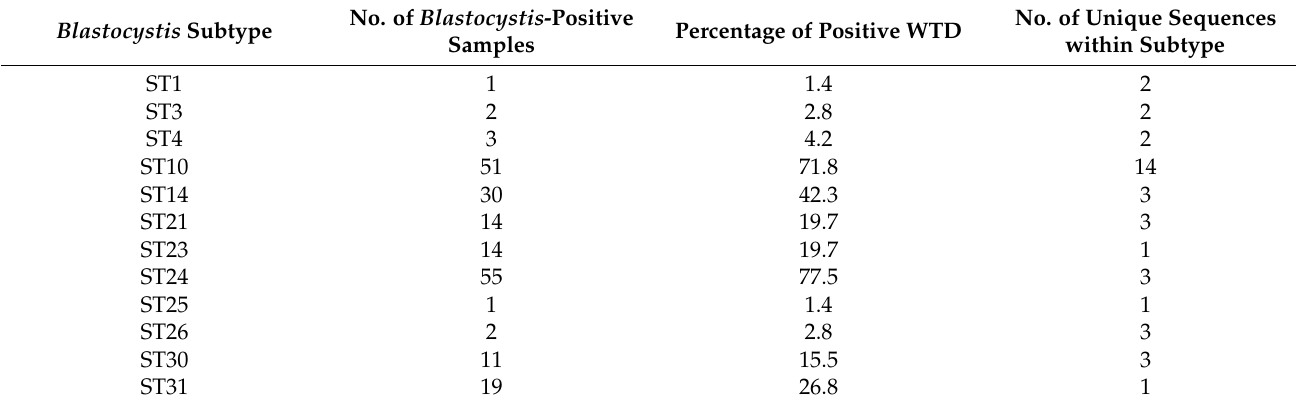
Table 3. Blastocystis subtypes identified in white-tailed deer (WTD) from Maryland (USA) including number of samples in which each subtype was identified and number of unique sequences among each